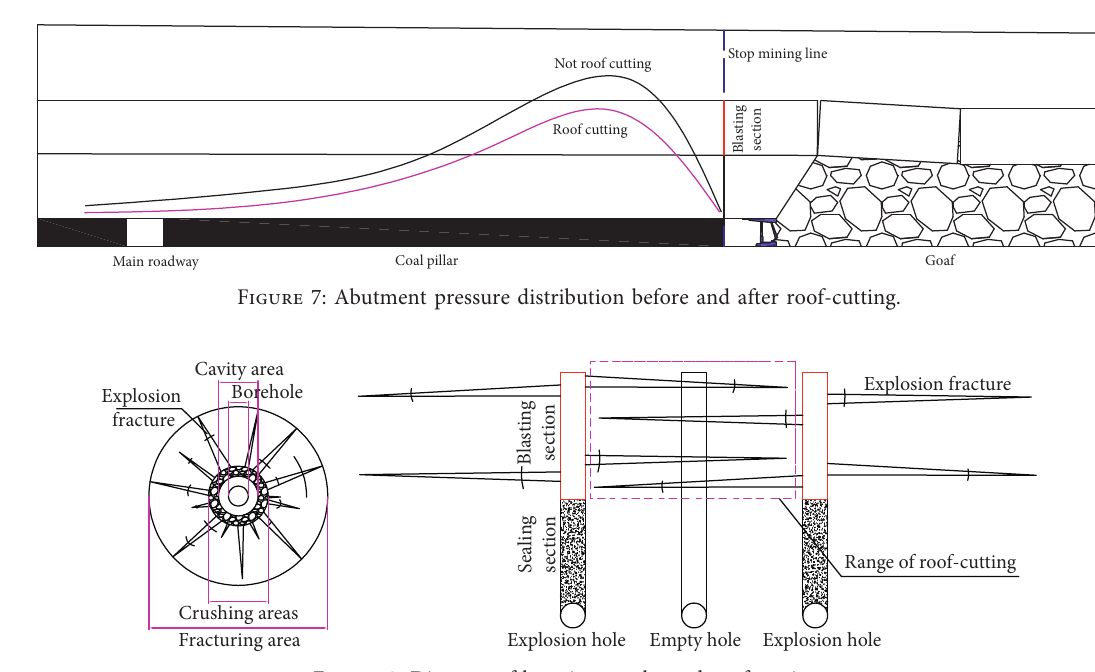
Figure 8: Diagram of bursting cracks and roof